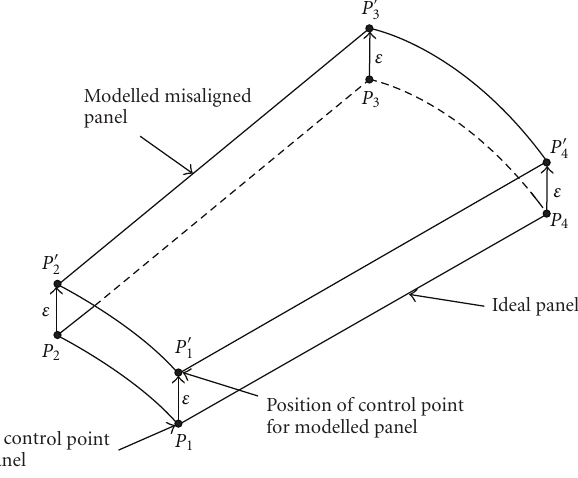
Figure 5: GRASP CAD modelization of a panel.